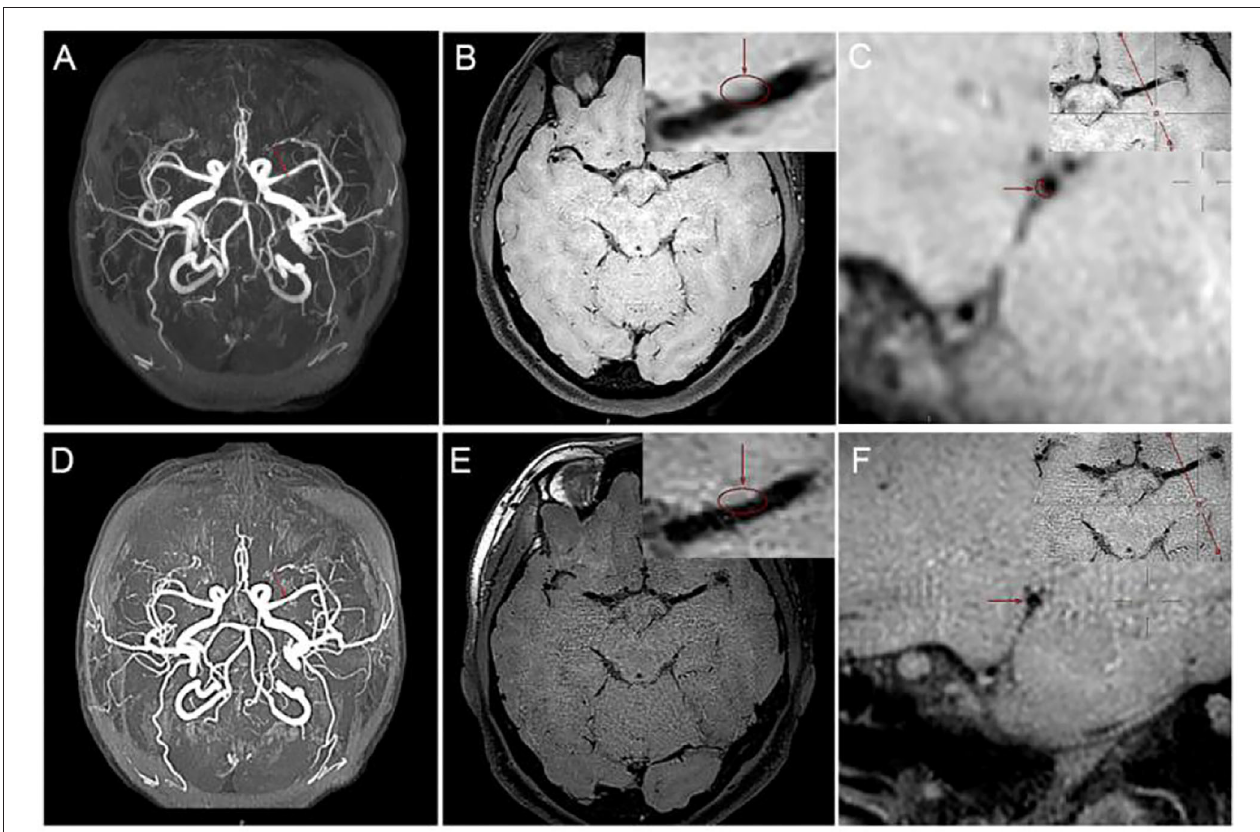
FIGURE 2 | High-resolution MRI (HR-MRI) examination at hospitalization. (A) Time of flight (TOF) magnetic resonance angiography (MRA) showed severe M1 stenosis in the left middle cerebral artery (MCA). (B) T1-weighted volume isotropic turbo spin-echo acquisition (T1W-VISTA) showed the location of the plaque and thickens the eccentric canal wall. T1W-VISTA also showed no significant enhancement on the plaque or surface, similar to the surrounding tissue signals, indicating no thrombosis on the surface of the plaque. (C) 3D-VISTA reconstruction was carried out at the maximal-lumen-narrowing site, and the rough shape of the patch was hand-drawn. HR-MRI examination after 24 months. (D) TOF MRA showed that the degree of lumen stenosis was significantly reduced. (E) T1W-VISTA showed that there were still some plaques on the tube wall, and the lumen was slightly narrow. (F) 3D-VISTA reconstruction showed the diameter of the tube was significantly